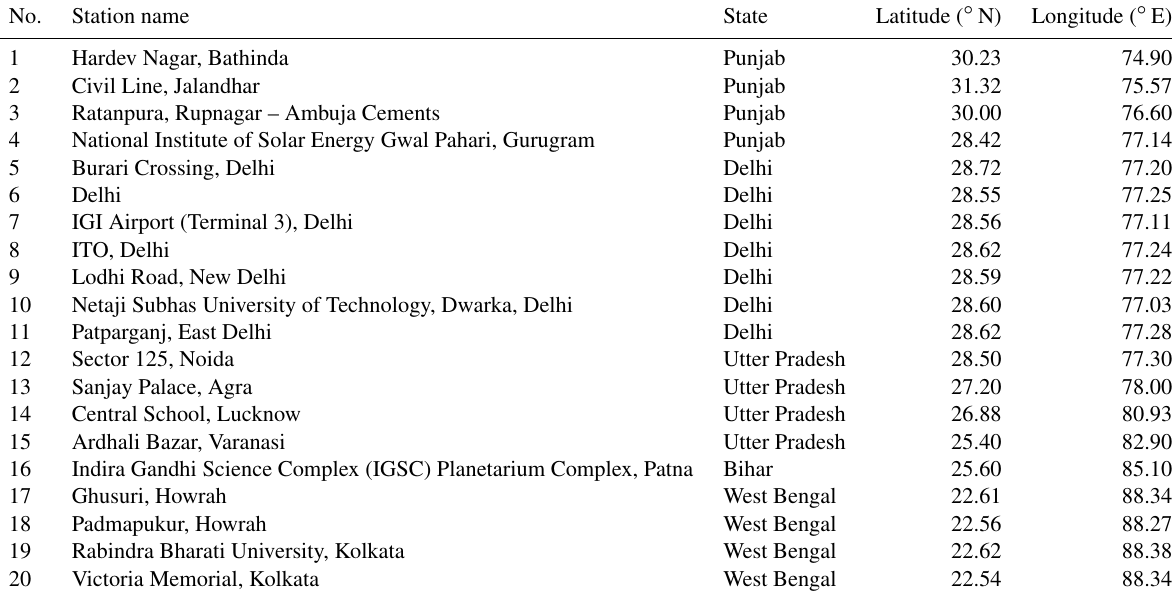
Table 2. List of ground-level measurement stations used for this study.